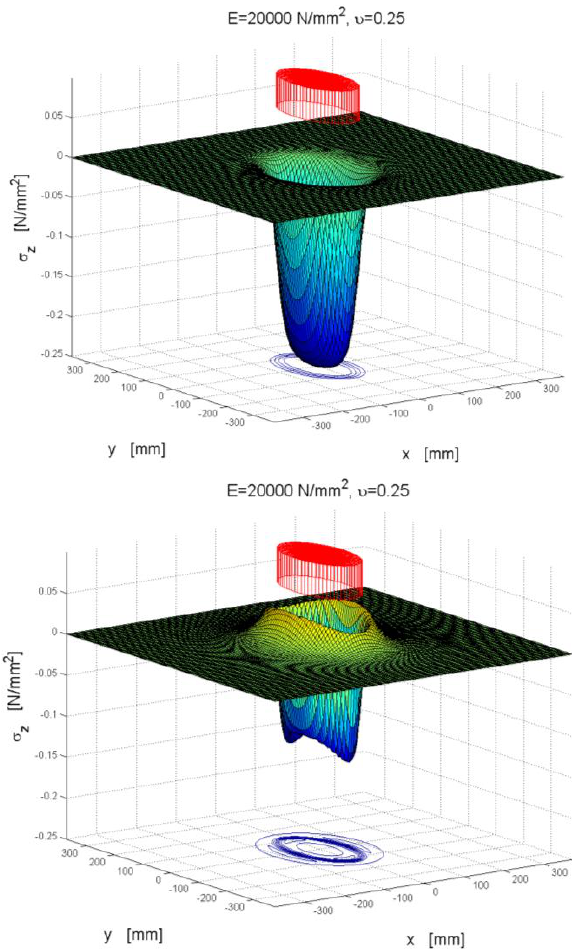
Figure 21: Uniform load distribution over an elliptical tire-ground contact area (the A-A vertical section is taken along the cross- section of the wheel).